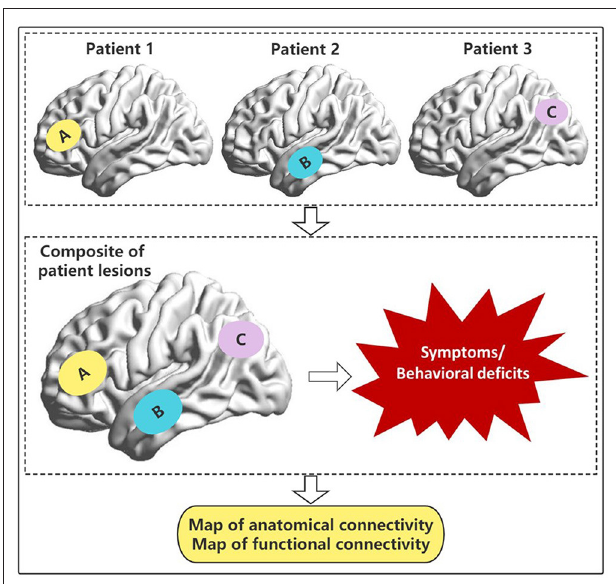
FIGURE 2 | Lesions or destruction of patients in different brain regions or networks (A–C) leads to similar symptoms or behavioral deficits. Based on the connectome, it is possible to explore whether there are common anatomical and/or functional connected brain